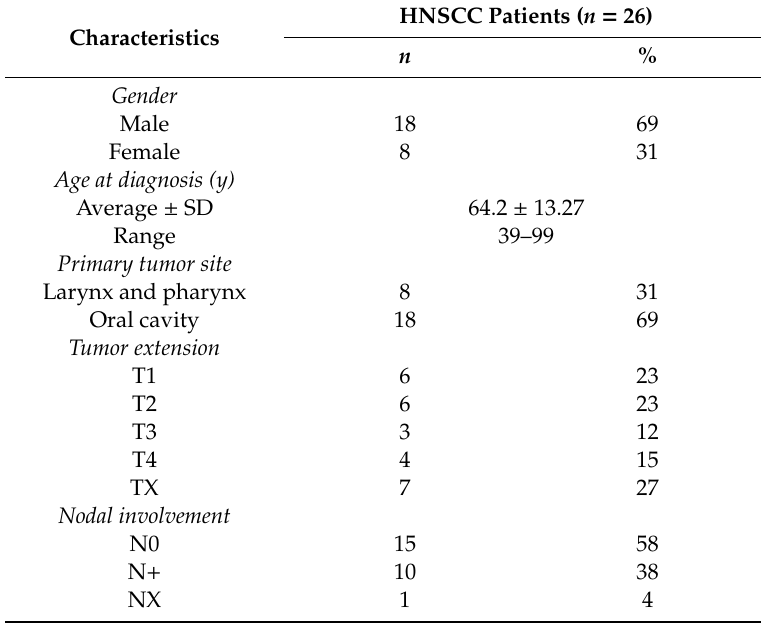
Table 3. Clinicopathological characteristics of the HNSCC patients included in this